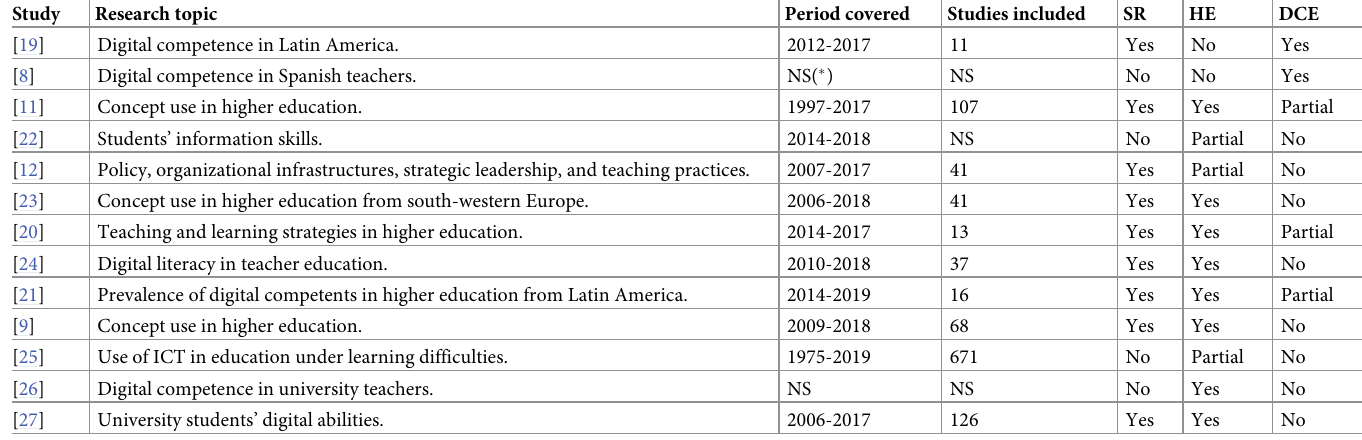
Table 1. Review of articles published in the last 5 years on digital competence 1) with a systematic review (SR), 2) covering higher education (HE), and 3) addressing digital competence evaluation (DCE). Study Research